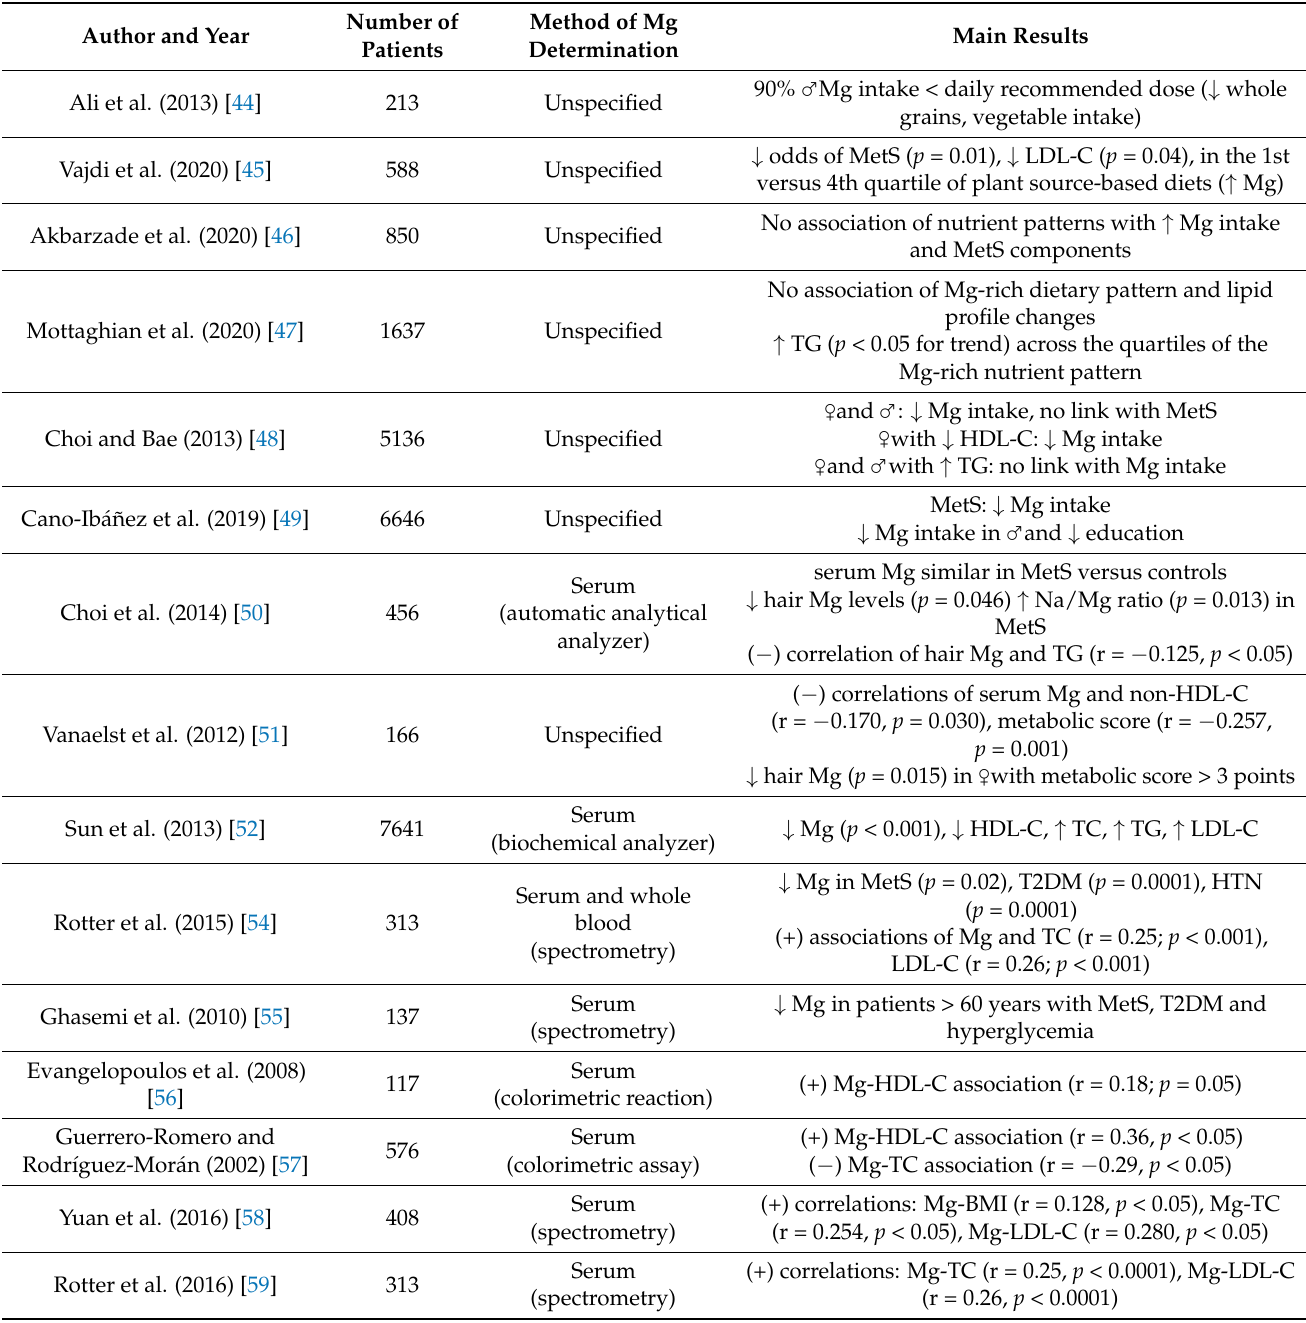
Table 2. Magnesium and serum lipids interplay in